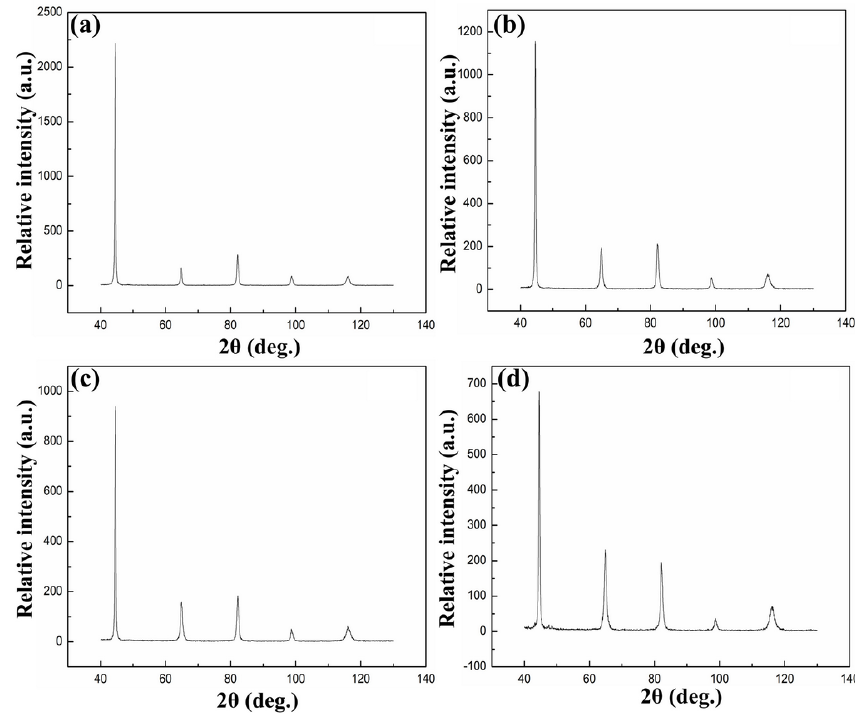
Figure 15. The X-ray diffraction (XRD) spectrums of non-shot peening and shot peening specimens: ( a ) NP specimen; ( b ) SP1 specimen; ( c ) SP2 specimen; ( d ) SP3 specimen.